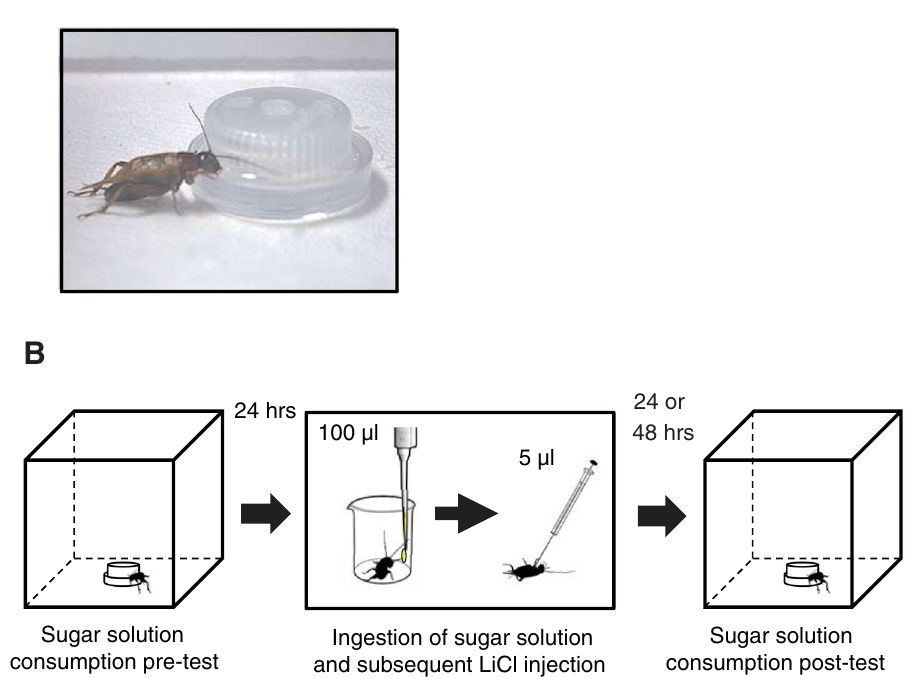
Figure 1. Experimental procedures for CTA training and testing in crickets. ( A ) A feeder used for the sugar consumption test. ( B ) CTA training to ingest 100 µl sugar solution followed by injection of 5 µl of 1 M LiCl solution. The amount of consumption of sugar solution for a given period of time was measured 24 h before CTA training and 24 or 48 h after CTA